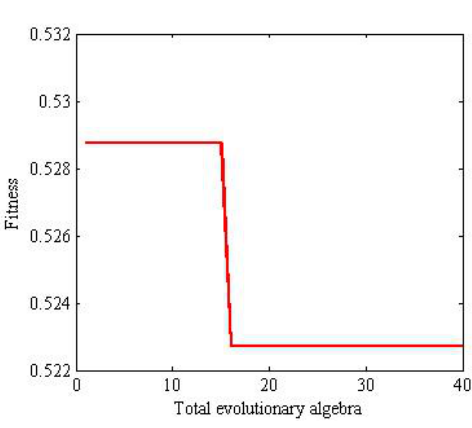
Fig. 10. Fitness curve of ABC algorithm